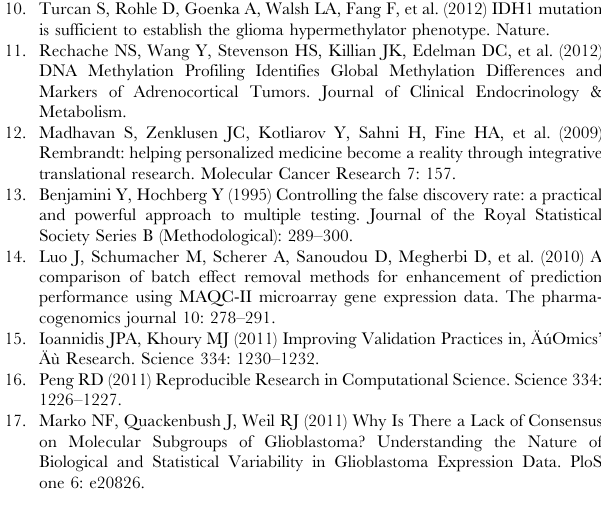
Figure S10 Methylation sites in different categories are represented with respect to methylation-expression correlations (Pearson). Table S1 Prediction models with 10 probe sets. Table S2 Prediction models with 25 probe sets. Table S3 Prediction models with 50 probe sets. Table S4 Prediction models with 100 probe sets. Table S5 Prediction models with 200 probe sets. Table S6 Prediction accuracy of the G-CIMP